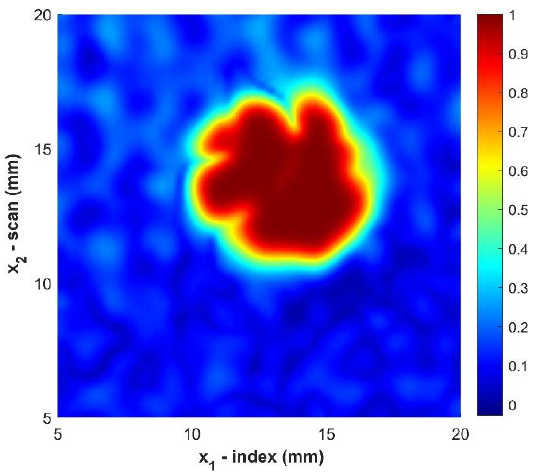
Figure 7. C-Scan of sample B2 using only interpolation. Color indicates the normalized amplitude of the ultrasonic data.